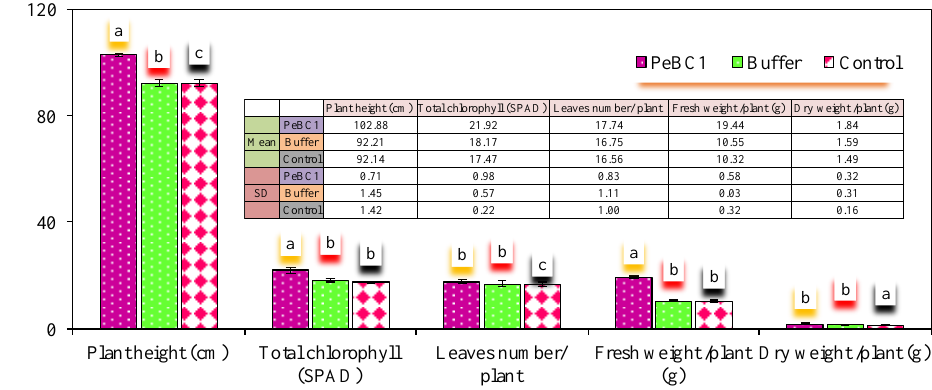
Figure 7. Influence of PeaT1 and PeBC1 on the growth of treated chili seedlings ( A , B ). Average growth parameters with ( ± SE) of chili plants in PeaT1, PeBC1, buffer, and control-treated seedlings ( n = 10). Statistically, data were compared by the least significant difference (LSD), one-way analysis of variance (ANOVA), and Levene’s test in SPSS 18.0. Different lower style alphabets letters indicate a significant difference in different treatment patterns ( p = 0.05).